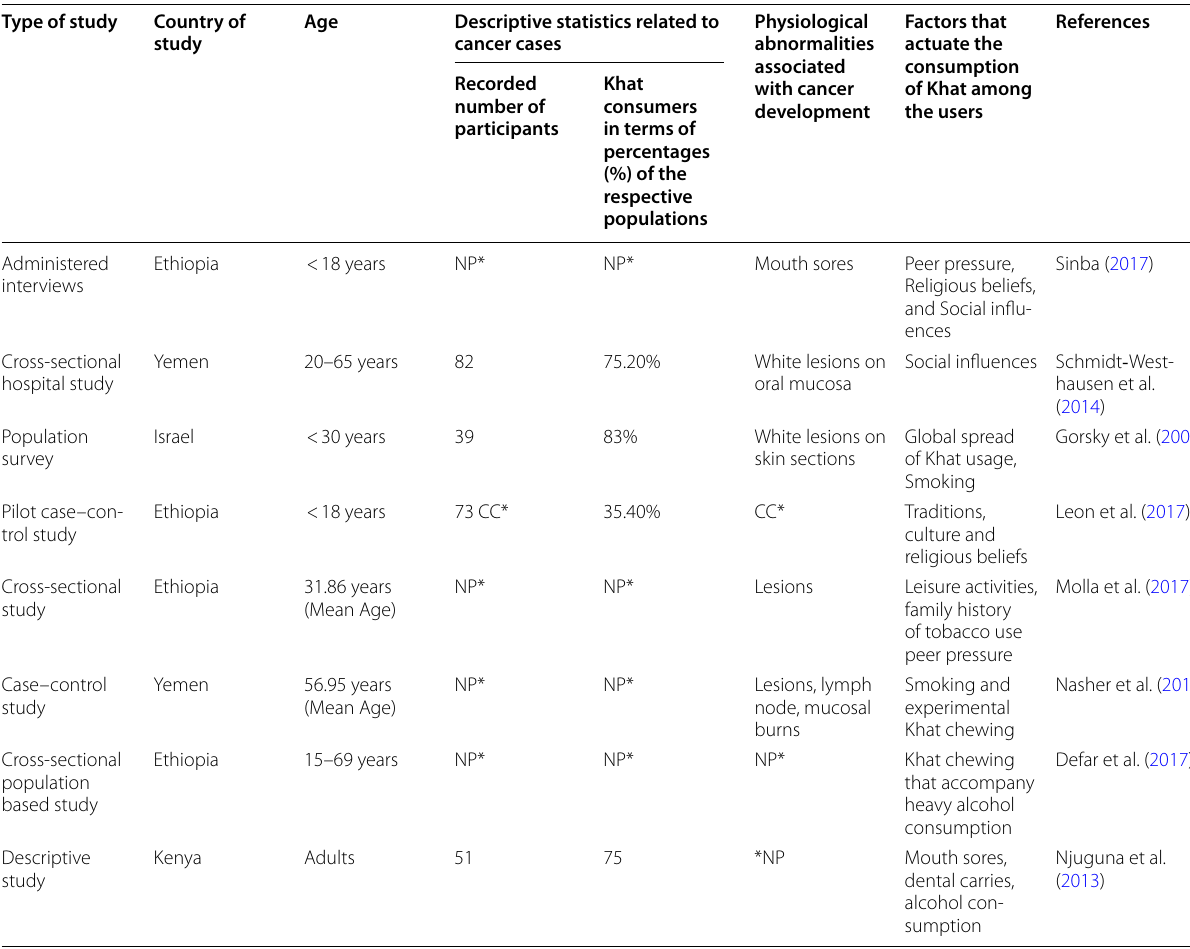
Table 7 Selected demographic characteristics of khat users, the related physiological symptoms of cancers and the factors actuating consumption of